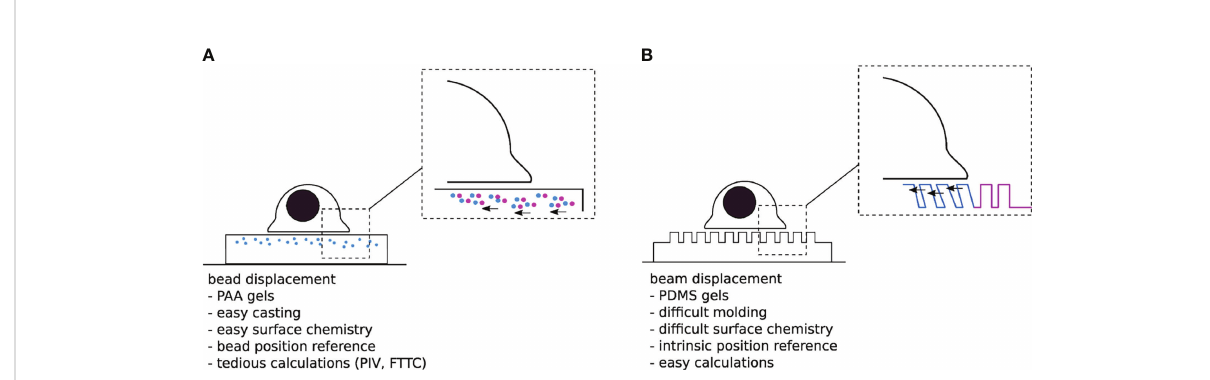
FIGURE 2 (A) “ Traditional ” TFM with PAA gels doped with sub-resolution fl uorescent beads. One dif fi culty is to assess the non-perturbed bead position either at the beginning or the end of the experiment. (B) Micropillar based TFM. The typical size of a pillar is 1µm diameter over 10µm length, for a 1 µm interpillar distance, and a hexagonal compact 2D distribution-the numbers given here are typical orders of magnitude for these parameters). The unmolding step in the substrate fabrication process can be quite delicate, while the force localization and calculation are rather